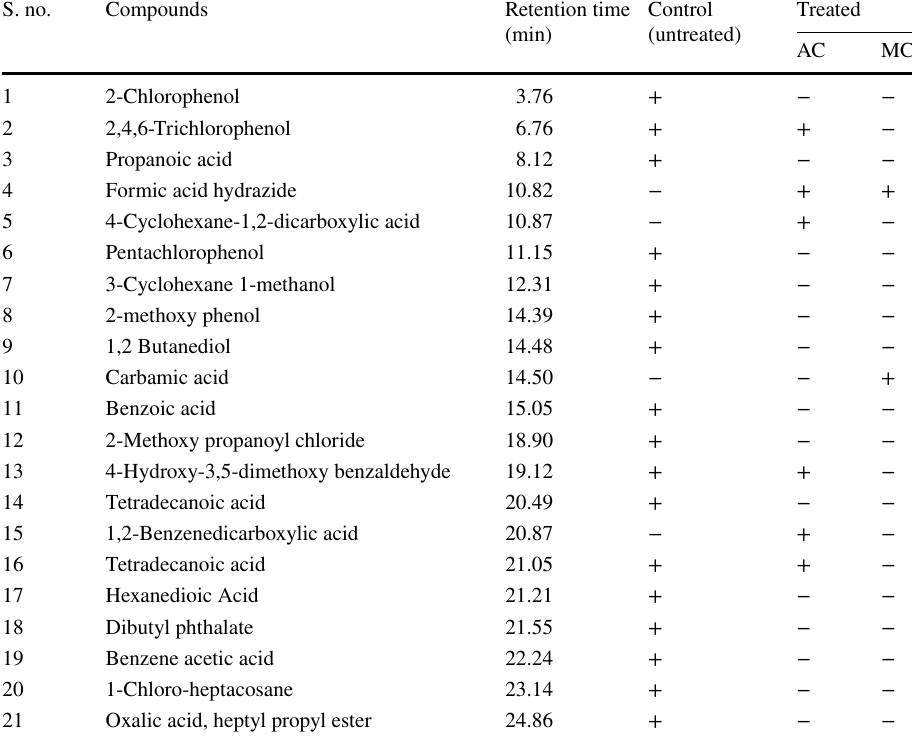
(+) present; (−) absent; (AC) axenic culture; (MC)